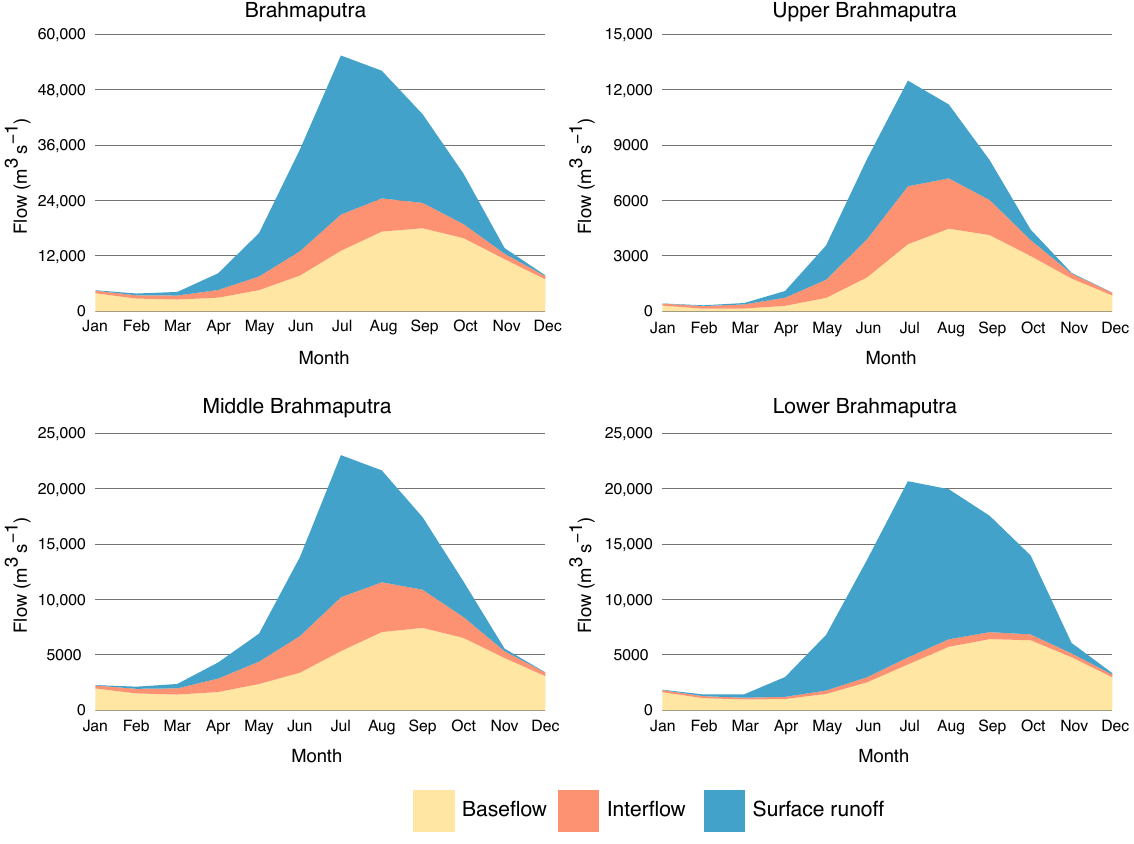
Figure 10. Average monthly contribution of different flow components to monthly water yield in the Brahmaputra basin and its three regions in